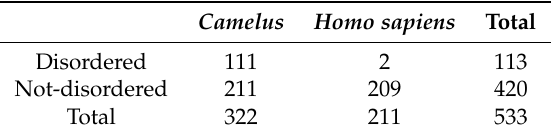
Table 3. Representative contingency table (2 × 2) constructed for all GO terms common to Camelus and Homo sapiens , in this case for term